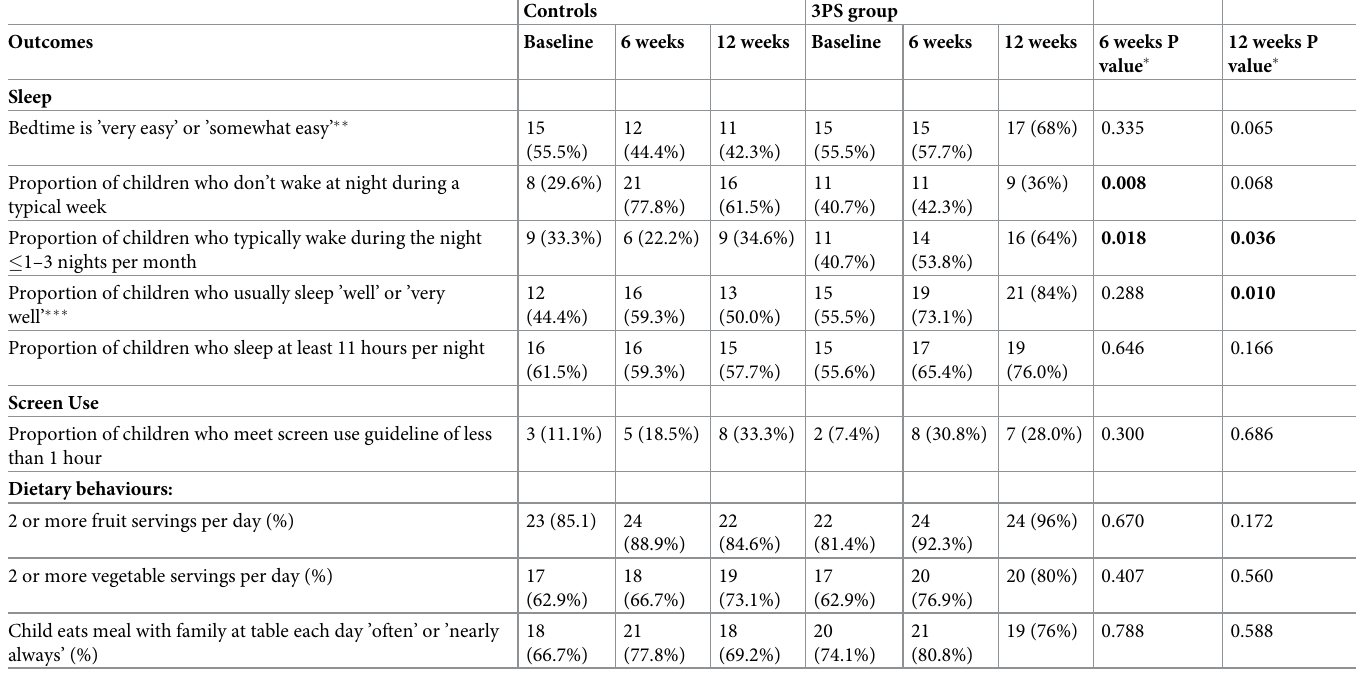
Table 3. Summary of binary outcomes and P value for difference between groups (excluding